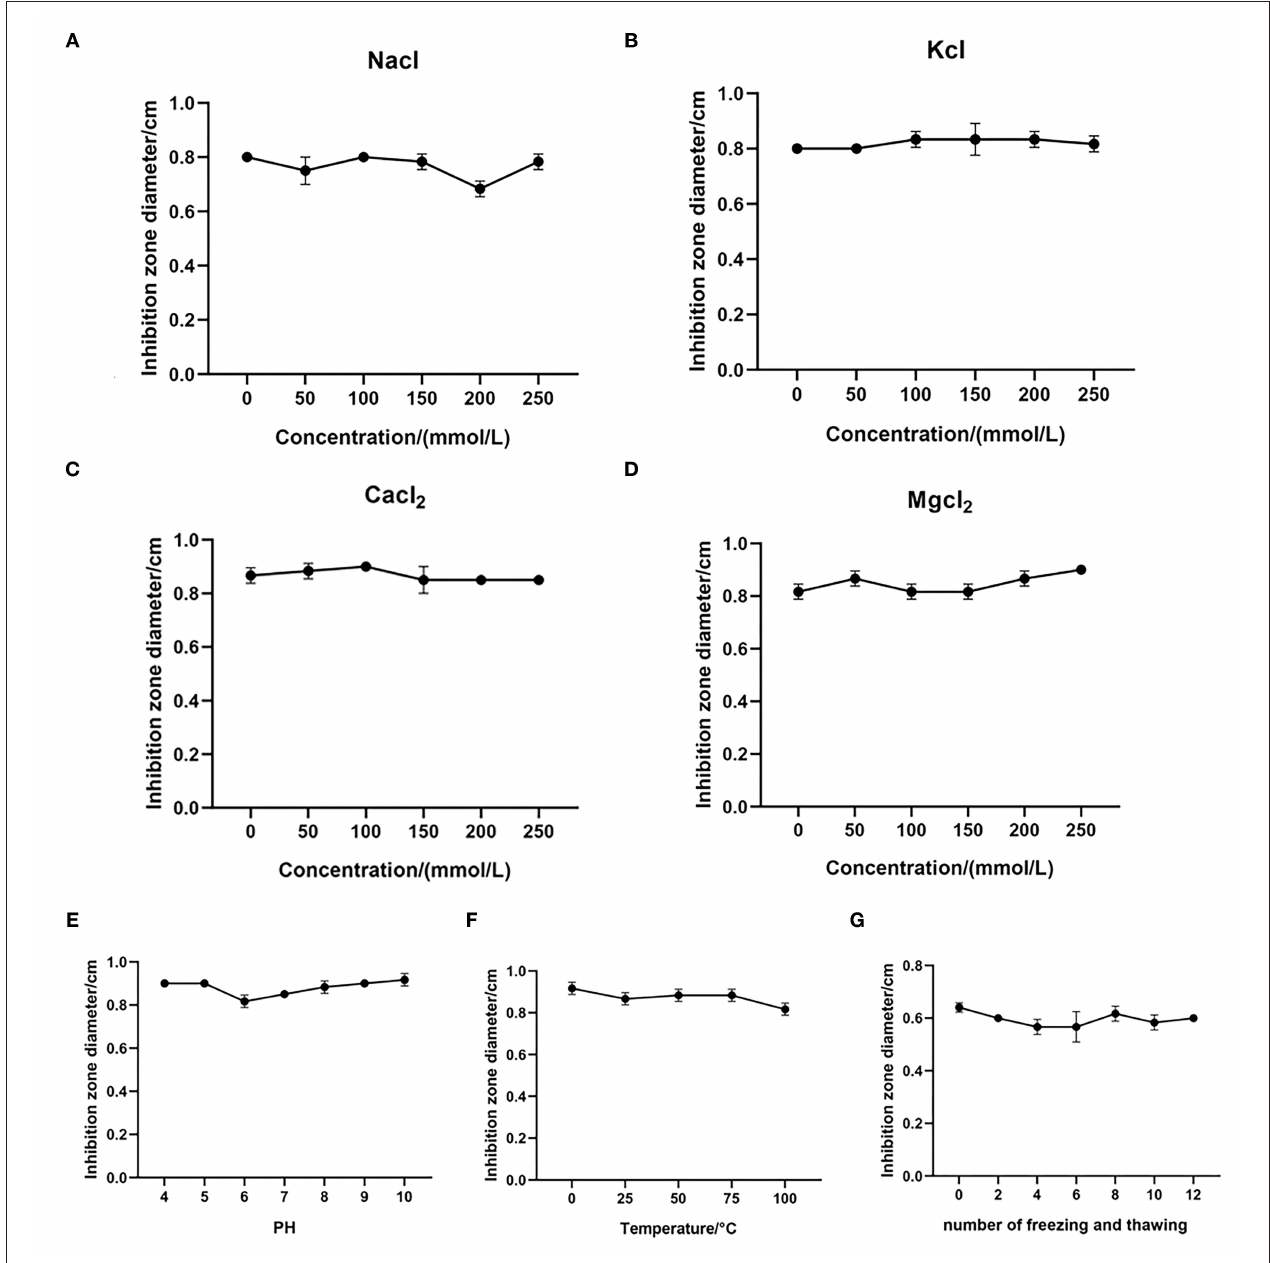
FIGURE 2 | Stability test of MPX. (A–D) The effect of different concentrations of NaCl, KCl, CaCl 2 and MgCl 2 on the antibacterial activity of MPX. (E) The effect of different temperatures on the antibacterial activity of MPX. (F) The effect of different pH values on the antibacterial activity of MPX. (G) The effect of repeated freezing and thawing on the antibacterial activity of MPX. Error bars indicate the mean ± SEM, n =